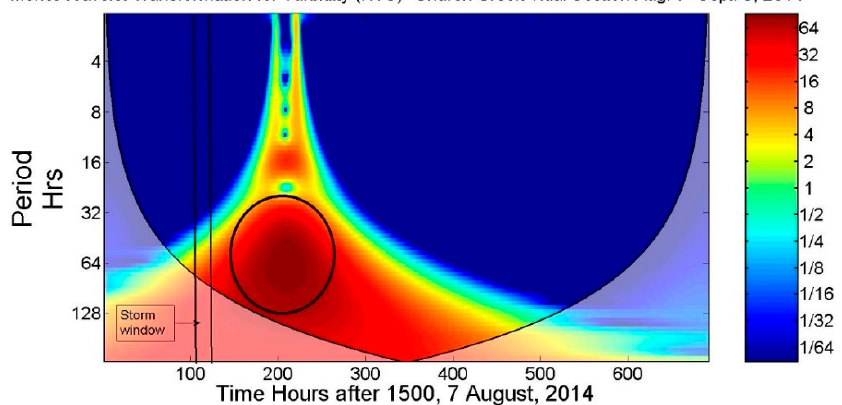
Figure 12. Morlet continuous wavelet transform of turbidity (NTUs) was captured from 7 August to 5 September 2014 in the Church Creek Triblet. The black circle represents 95 percent confidence above red noise. The bottom boundary is the cone of influence. Peak energy occurs at 64–75 h or 3-day periodicity.